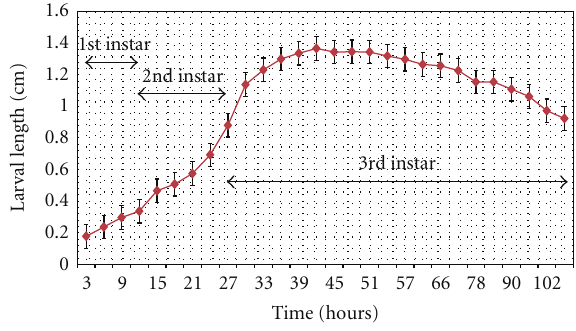
Figure 6: Relation between developmental time and the larval length of Hemipyrellia ligurriens under natural ambient conditions (26.7 ± 0.61 ◦ C; 74 ± 3% RH) of Phitsanulok province, northern